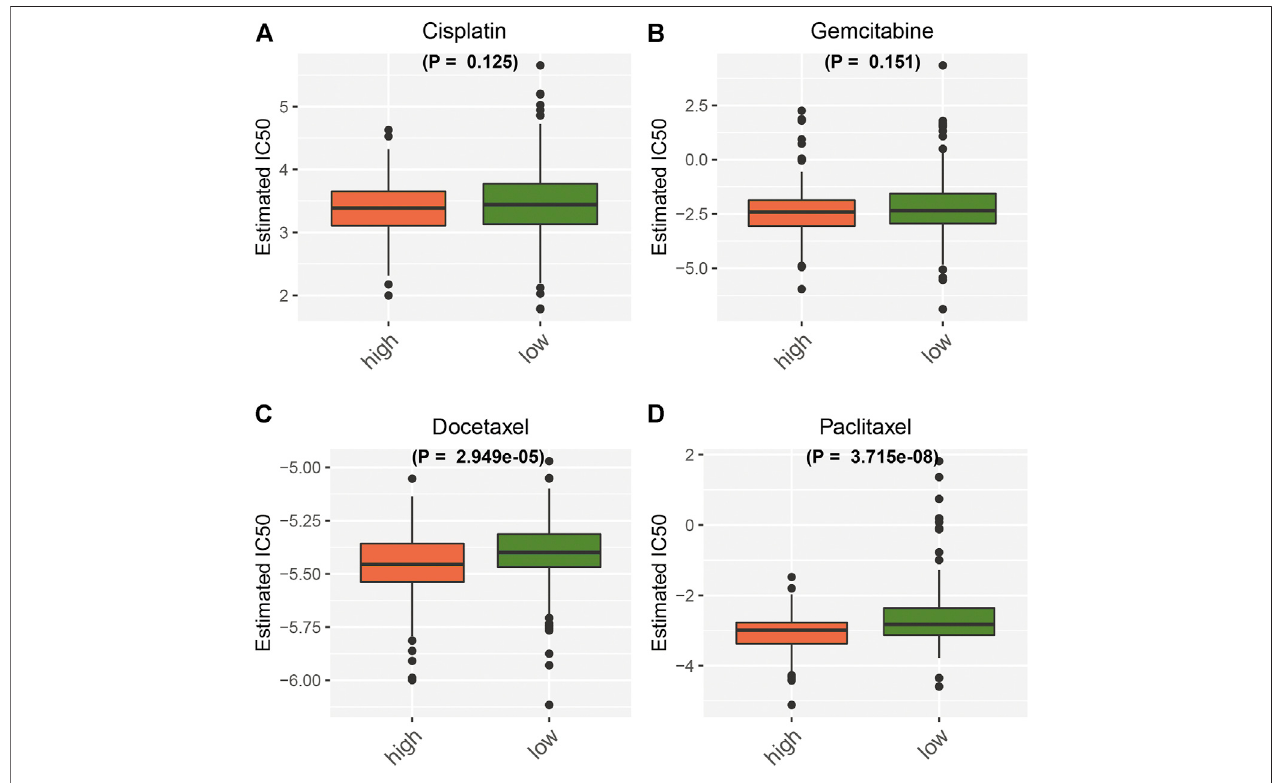
FIGURE 9 | Necroptosis-relevant risk model correlates with the chemosensitivity of pancreatic cancer. Box plots show the IC50 values of (A) cisplatin, (B) gemcitabine, (C) docetaxel, and (D) paclitaxel in high- and low-risk groups.